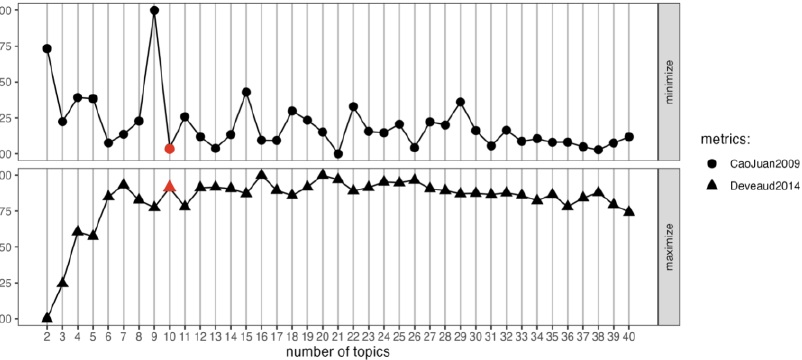
Figure 3. Number of topics tuning result.